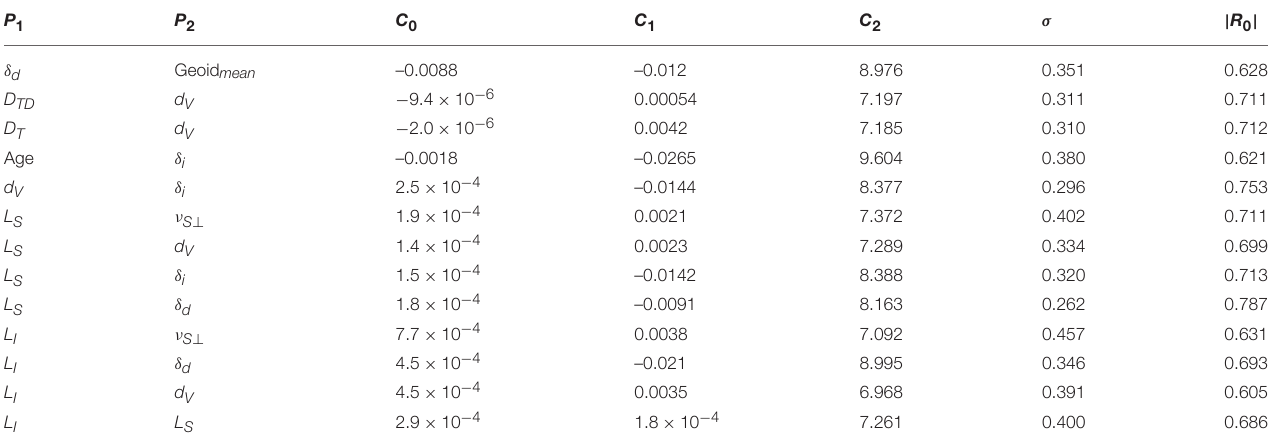
TABLE 5 | Overview 2D regression results and parameters to compute M max .